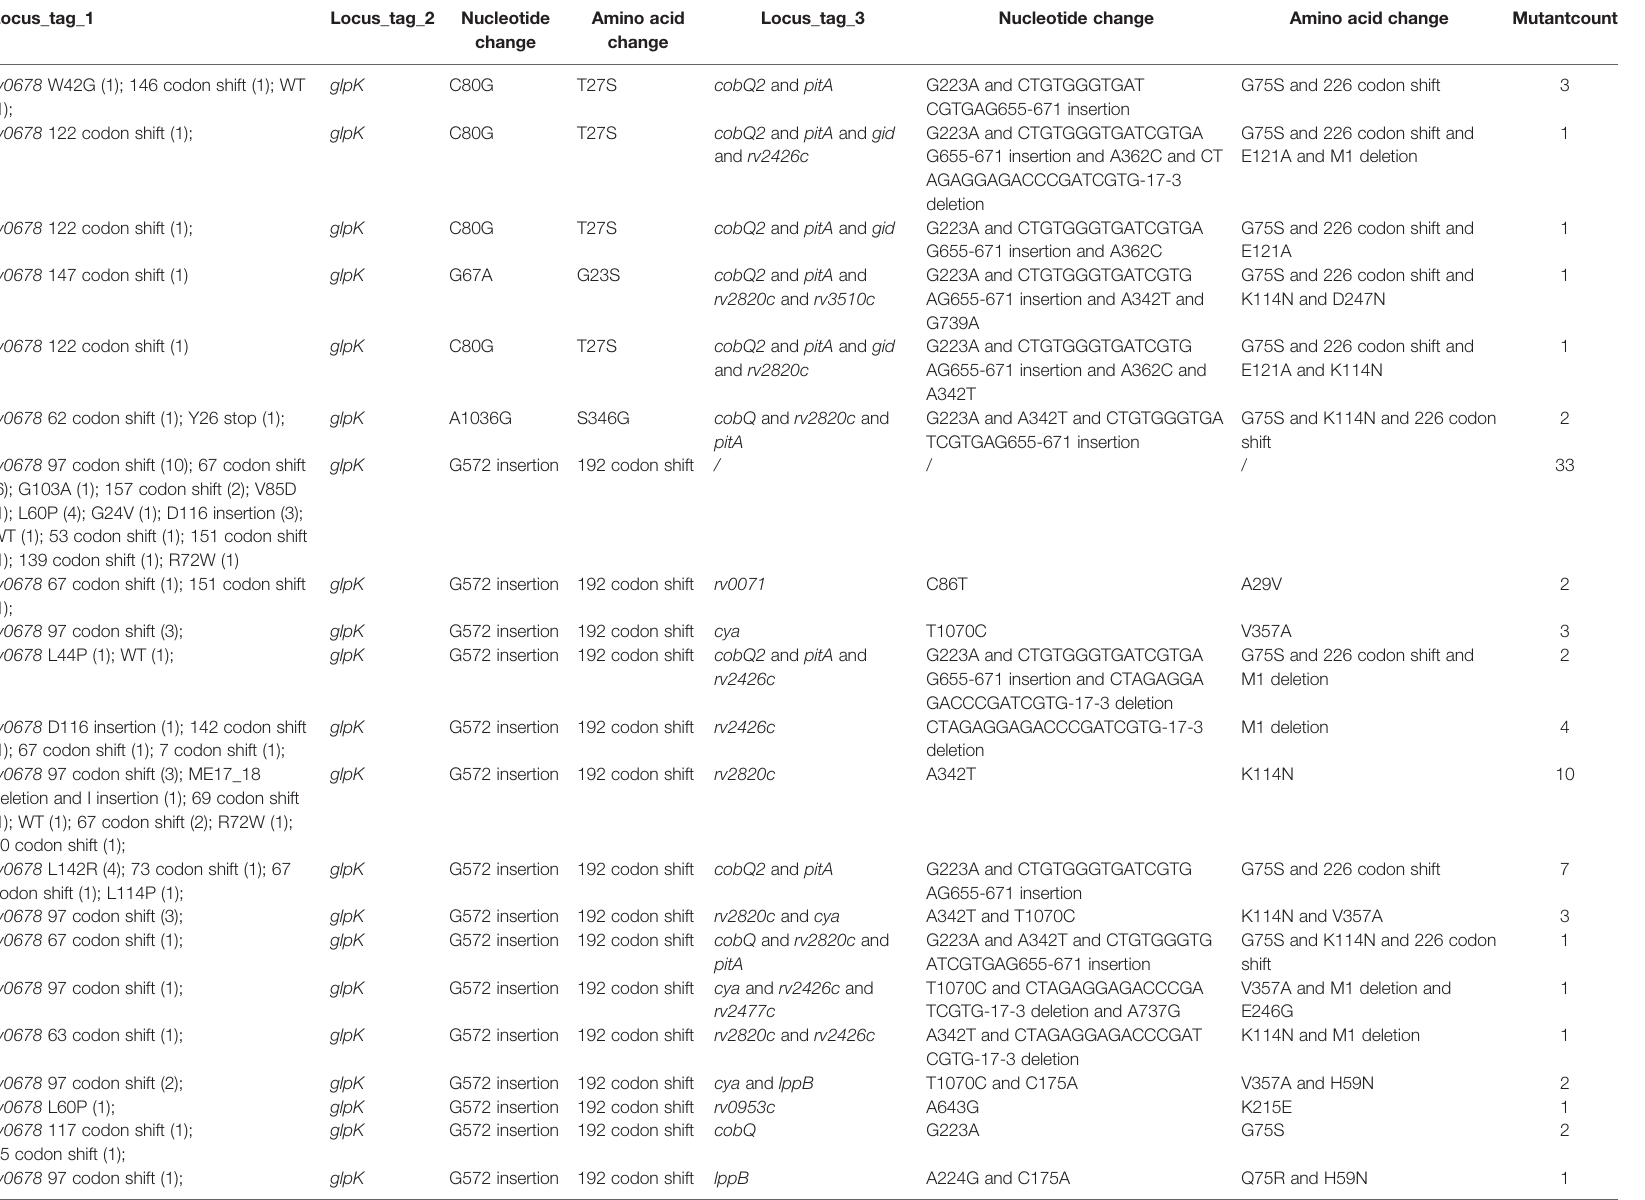
TABLE 3 | Hitchhiking mutations identi fi ed in BDQ-resistant mutants of